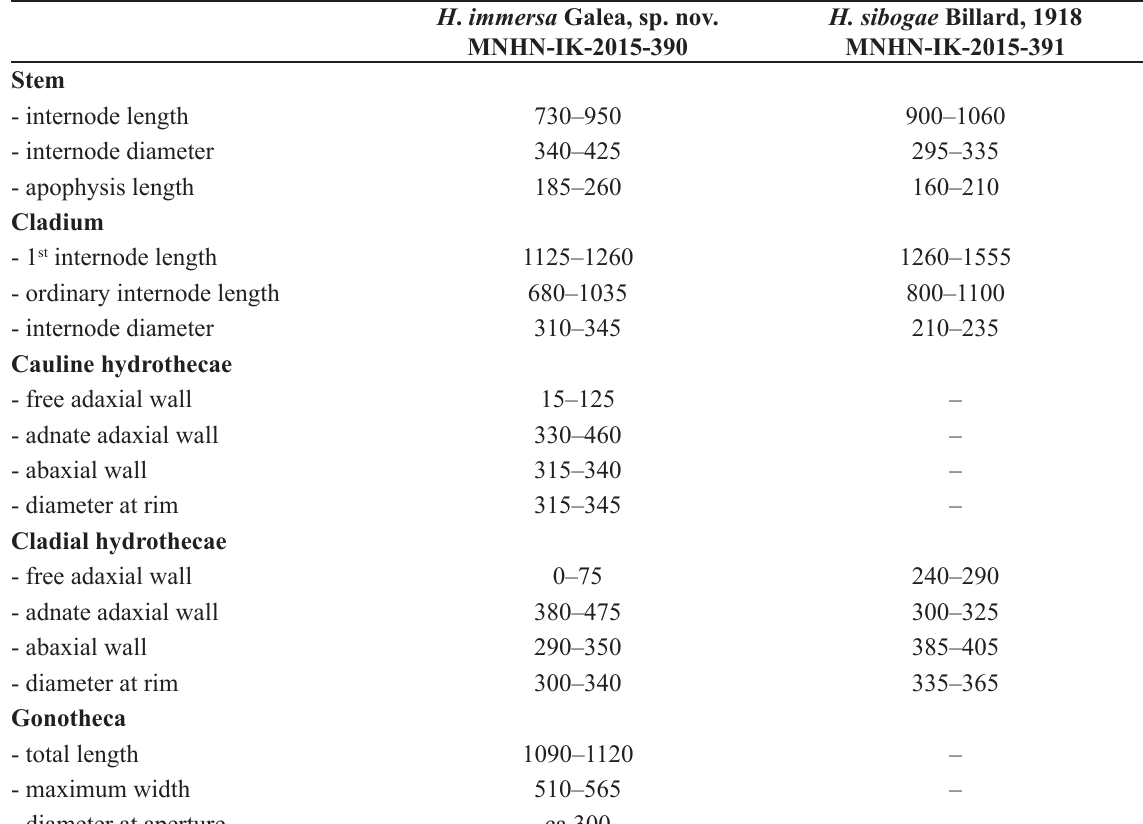
Table 3. Measurements of Hincksella spp., in